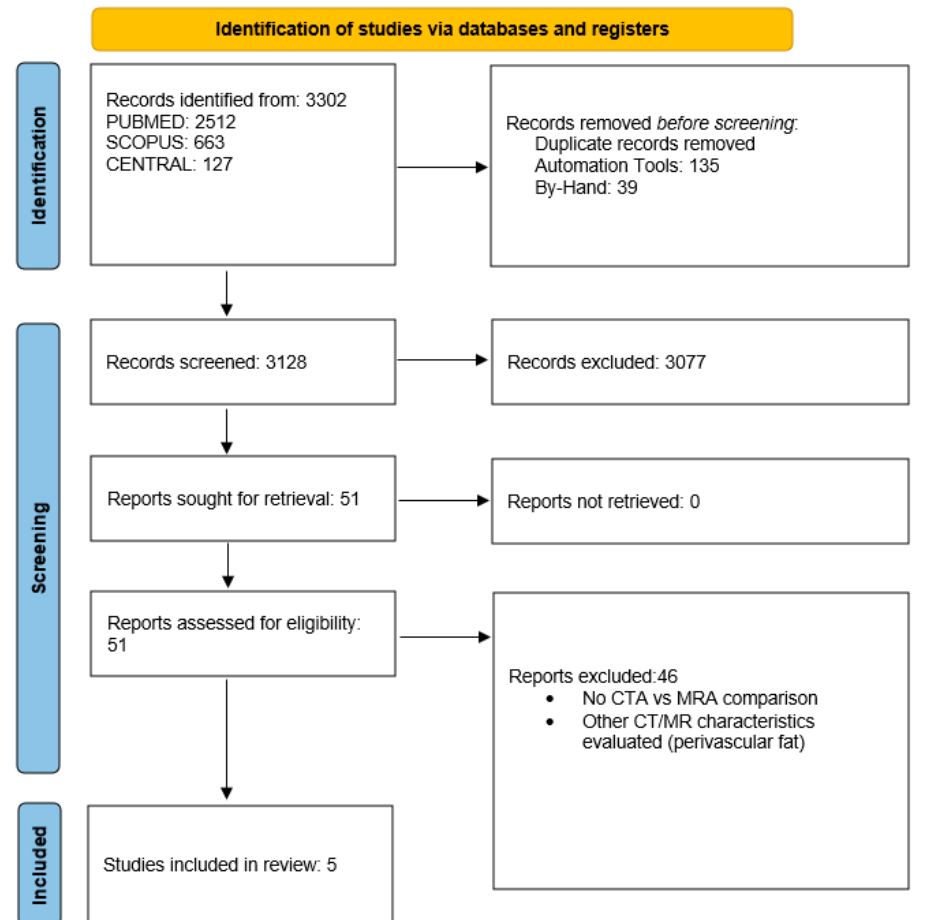
Figure 1. PRISMA 2020 flowchart. Screening process based on the PRISMA 2020 Guidelines for systematic reviews and meta-analyses. Table 1. Main study characteristics of the included